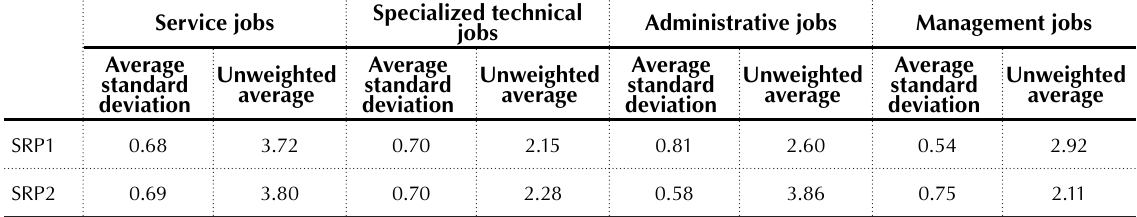
Table 7. Summary of main SRP coordinate values of the jobs in the Civil Department of the Isfahan Municipality Specialized technical Service jobs Administrative jobs Management jobs